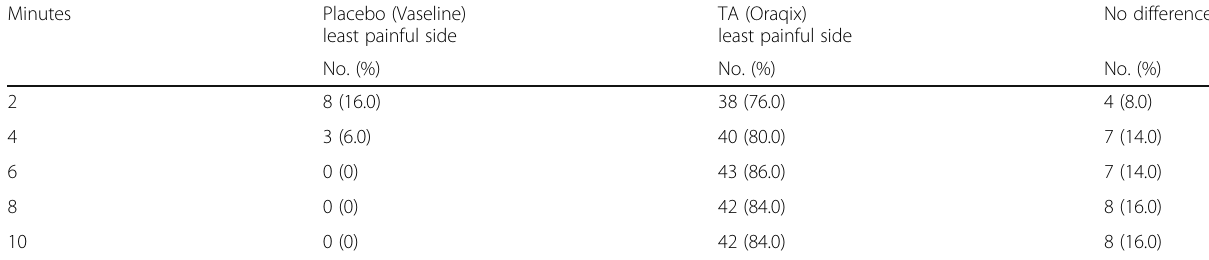
Table 2 The verbal scale displaying the number (no.) and percentage (%) of subjects reporting the placebo (Vaseline) side as the least painful side, the topical anesthesia (TA), Oraqix, side as the least painful side, and no difference between both sides concerning the least pain